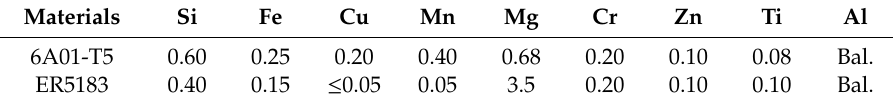
Table 1. Chemical composition of 6A06-T5 aluminum alloy and ER5183 filler wire